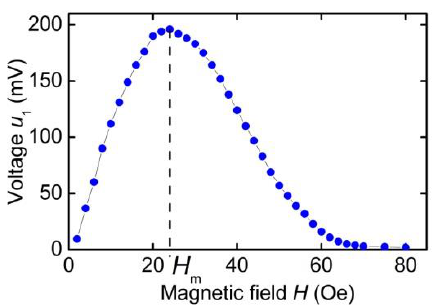
Figure 21. Dependence of the ME voltage u 1 on the field H for the Cu/Metglas-PZT-Metglas/Cu heterostructure at frequency f 1 .